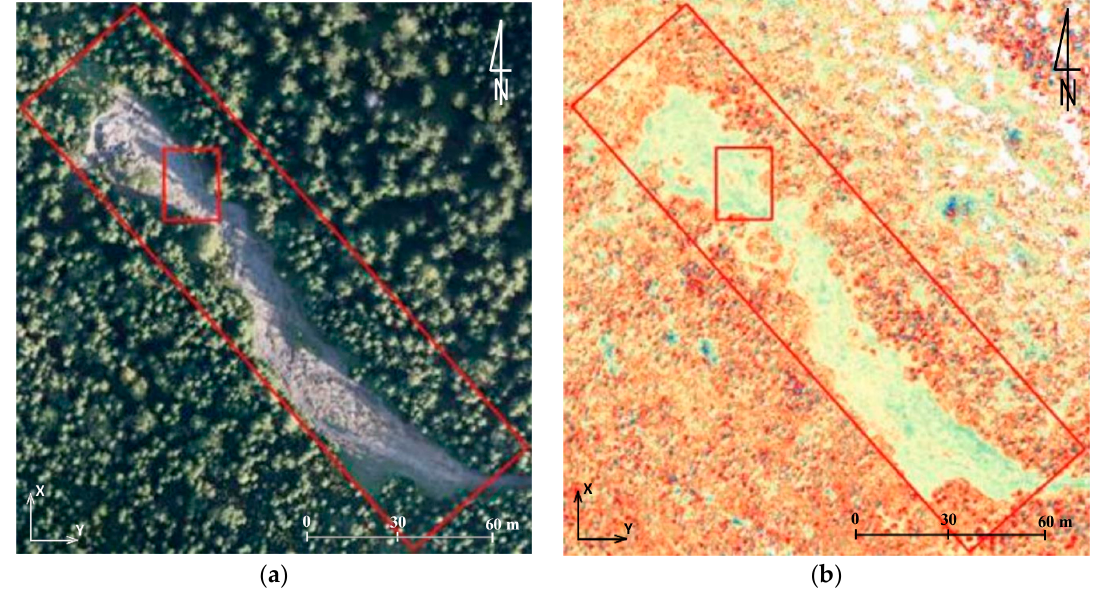
Figure 17. Field B: ( a ) ortophotomap, and ( b ) the results of comparison of DSM UAV–DSM ALS (source: authors’ own study).